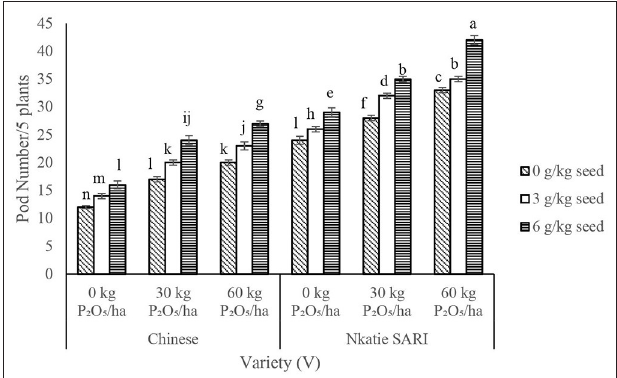
FIGURE 4 | Interactive effect of P-rate (PR) and inoculant rate (IR) on grain yield of groundnut grown in Haplic Lixisols of northern Ghana. Bars with different letters (in horizontal direction) show significantly different means. Error bars represent standard error of mean.